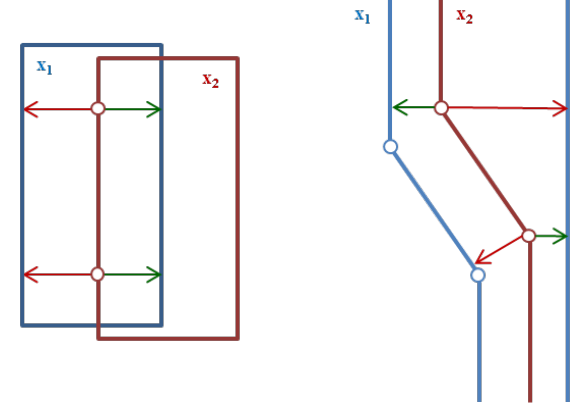
Figure 7. Assignment to the opposite side of the corresponding object (left), assignment to the wrong object (right) (green arrows: shortest